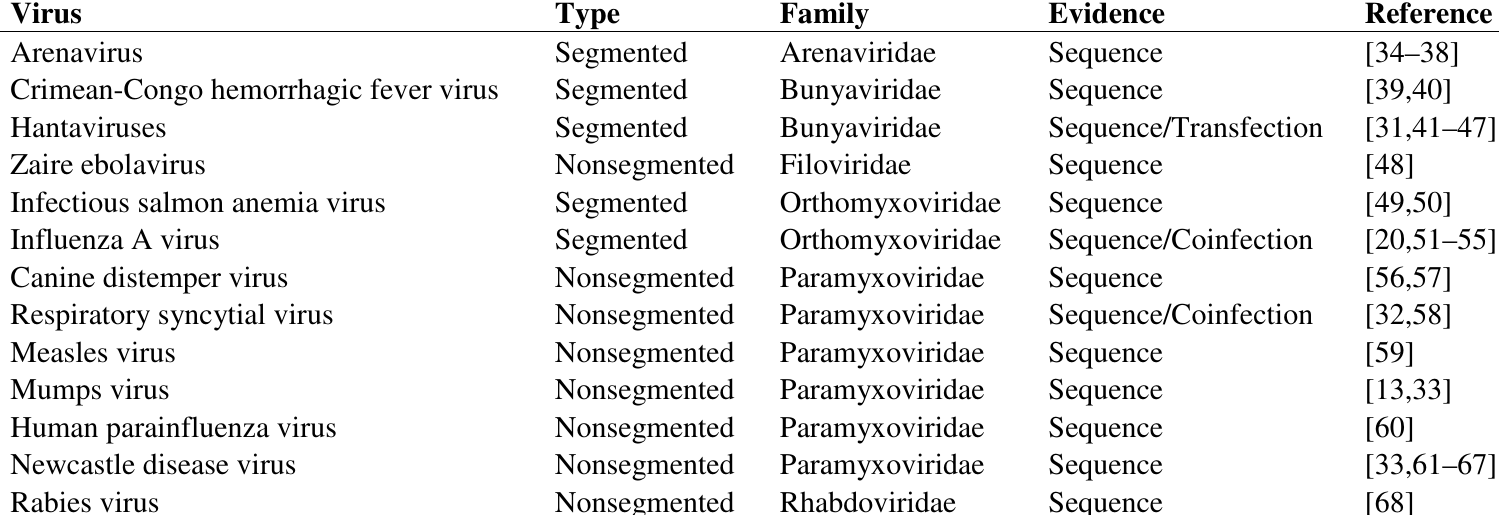
Table 1. List of reported recombination in negative sense RNA